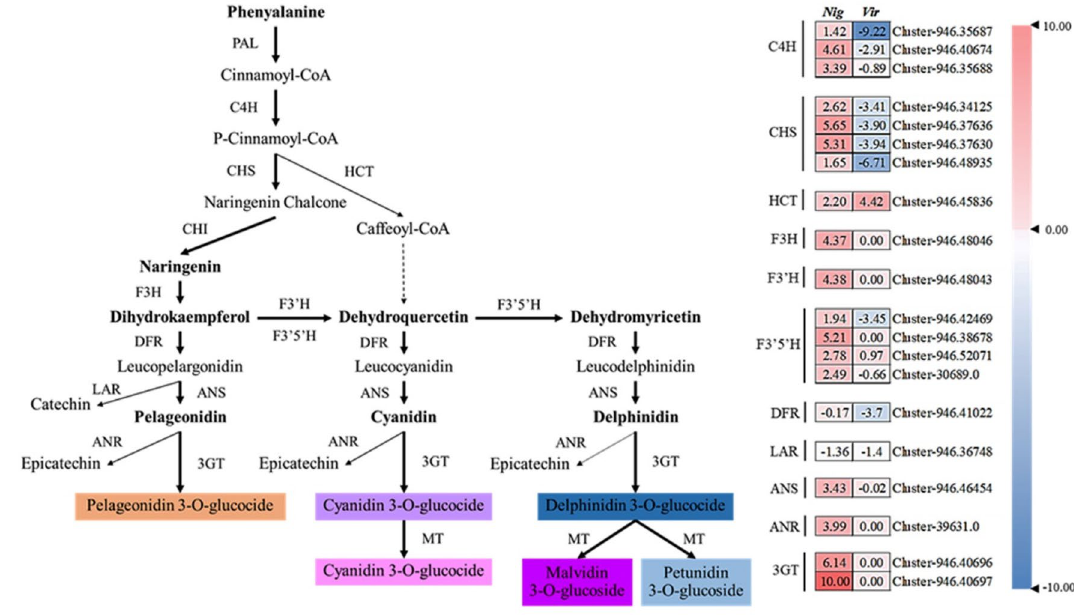
Figure 4. Simplified scheme and heatmap of the expression of genes related to flavonoid and anthocyanin biosynthesis in the exocarp of oil palm fruit of nigrescent ( Nig ) and virescent ( Vig ) types. Each colored cell represents the average log 2 (FPKM) value of each pathway gene according to the color scale. PAL, phenylalanine ammonia-lyase; C4H, cinnamic acid 4-hydroxylase; CHS, chalcone synthase; CHI, chalcone isomerase; HCT, shikimate O-hydroxycinnamoyl transferase; F3H, flavanone 3-hydroxylase; F3 ′ H, flavonoid 3-monooxygenase; F3 ′ 5 ′ H, flavonoid 3 ′ , 5 ′ -hydroxylase; DFR, dihydroflavonol-4-reductase; LAR, leucoanthocyanidin reductase; ANS, anthocyanidin synthase; ANR, anthocyanidin reductase; 3GT, flavonoid 3-O-glucosyltransferase; MT, methyl